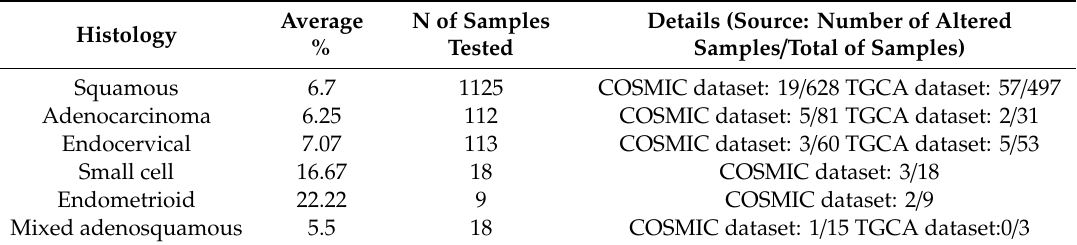
Table 3. Incidence of PTEN alterations in cervical cancer according to histotypes.